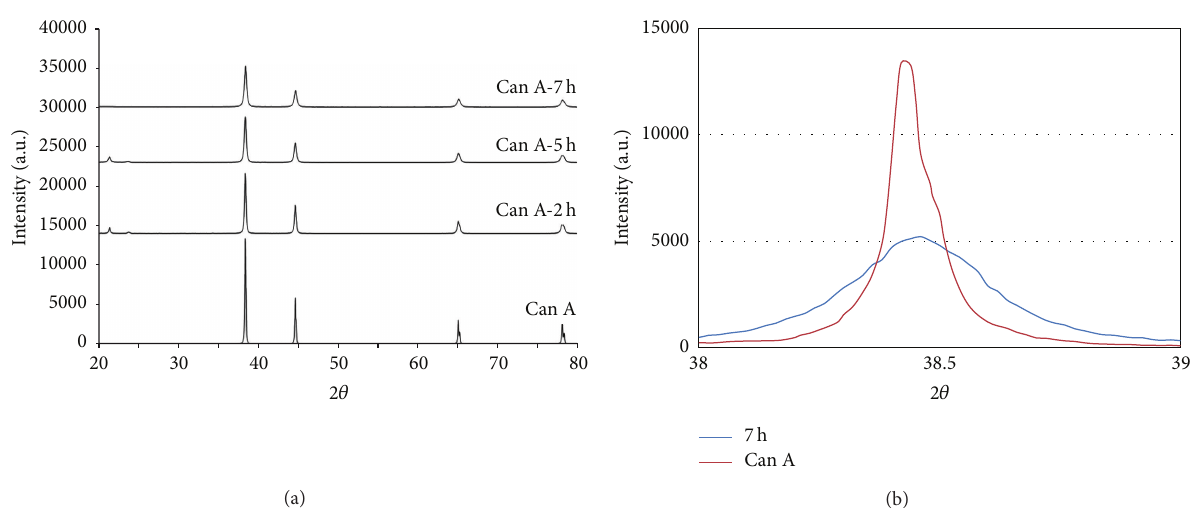
Figure 2: (a) XRD patterns for the cryomilled powders to different milling times, (b) the (111) XRD peak for the powders cryomilled for 7 hours and the standard sample.